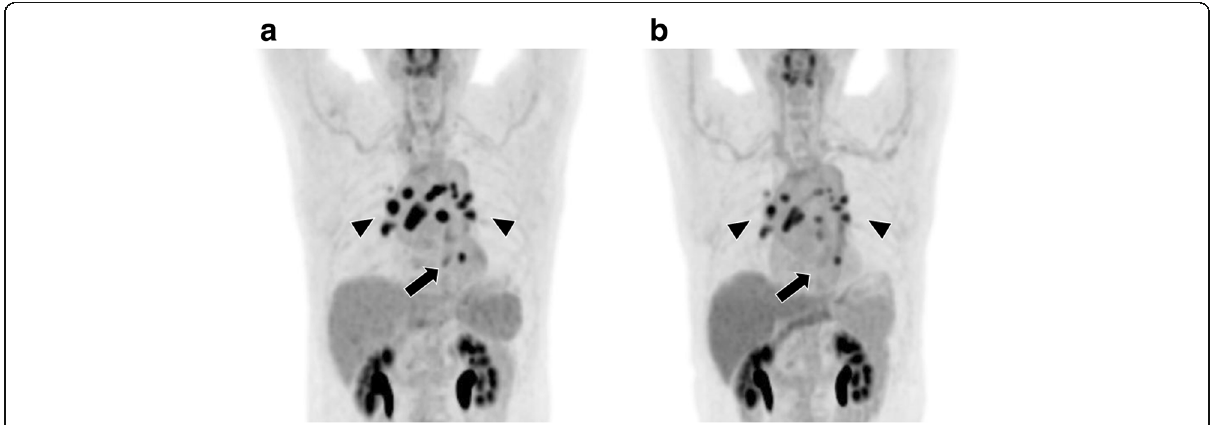
Fig. 1 FDG-PET/CT images obtained before ( a ) and after ( b ) chemotherapy in case 1. a Images obtained before chemotherapy show FDG accumulation in the primary cancer (arrow; SUV max: 4.06) and in the hilar-mediastinal lymph nodes (arrow head; SUV max: 15.0). b Images obtained after chemotherapy show a disappearance in FDG uptake in the primary cancer (arrow) and a slight reduction in FDG uptake in the hilar-mediastinal lymph nodes (arrow head; SUV max: